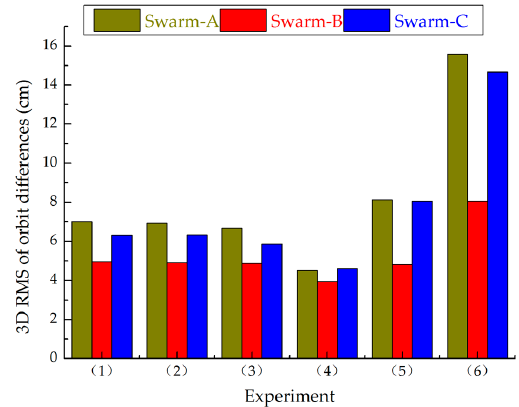
Figure 2. RMS values of orbit differences for all Swarm satellites in 3D direction between Swarm POD and Precise Science Orbits (PSOs) released by the European Space Agency (ESA), 1 November 2014.